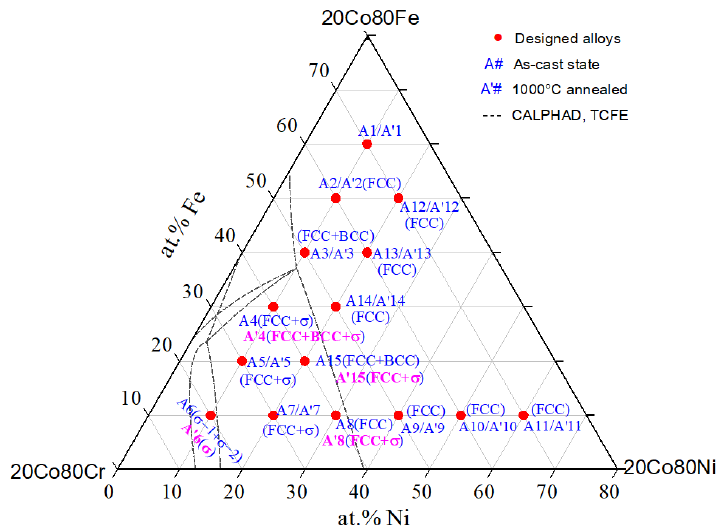
Figure 1. The detected phases in the as-cast and 1000 °C annealed 20Co-Cr-Fe-Ni alloys in the present work. The BCC phase was found in alloy A1 for there is an FCC → BCC transformation when cooling to the room temperature. The dotted line is the calculated phase region boundary of the 20Co-Cr-Fe-Ni system at 1000 °C based on the TCFE thermodynamic database [40] .